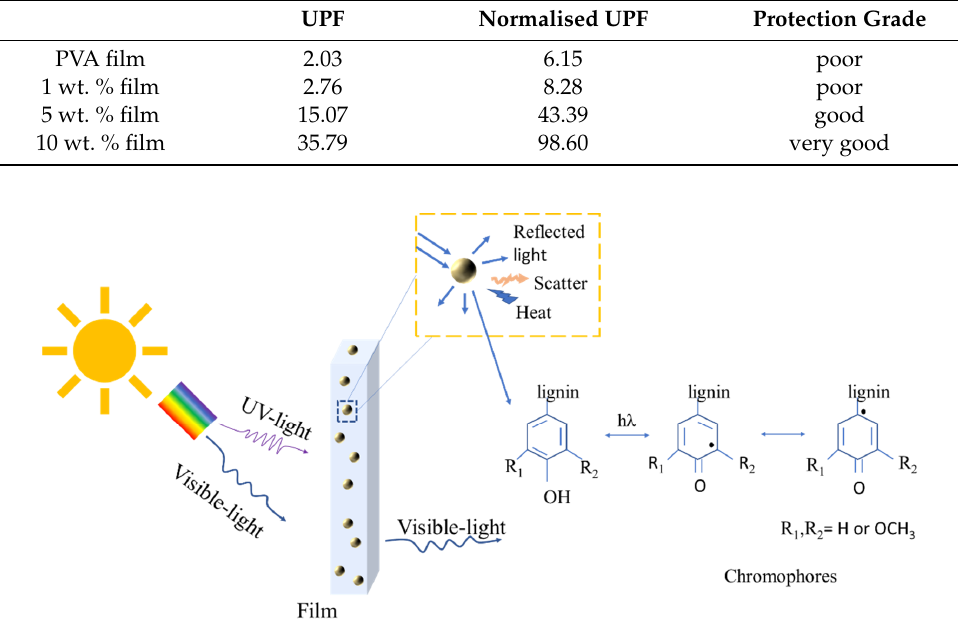
Table 3. Ultraviolet protection factor of the films (UPF).